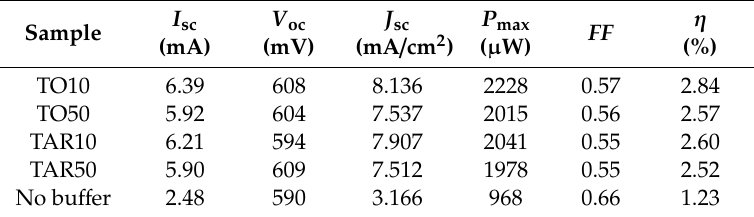
Table 3. Electro-optical parameters: Short circuit current ( I sc ), open circuit voltage ( V oc ), short circuit current density ( J sc ), maximum power ( P max ), fill factor ( FF ) and photovoltaic conversion e ffi ciency ( η ) of typical dye-sensitized solar cells (DSSCs) measured under standard illumination conditions (Figure